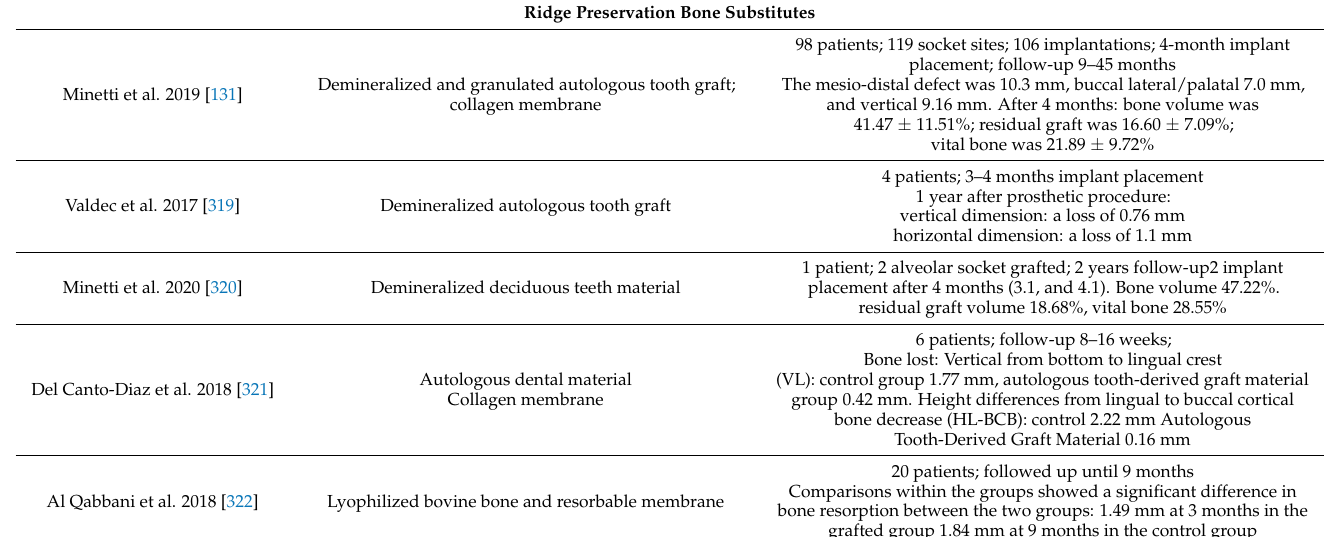
Table 4. Summary of the biomaterials and graftfor ridge preservation procedure. [T: Test; C; Control]. Ridge Preservation Bone